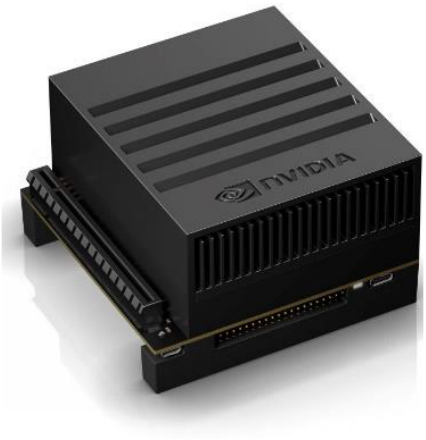
Figure 5. NVIDIA Jetson AGX Xavier Developer Kit.